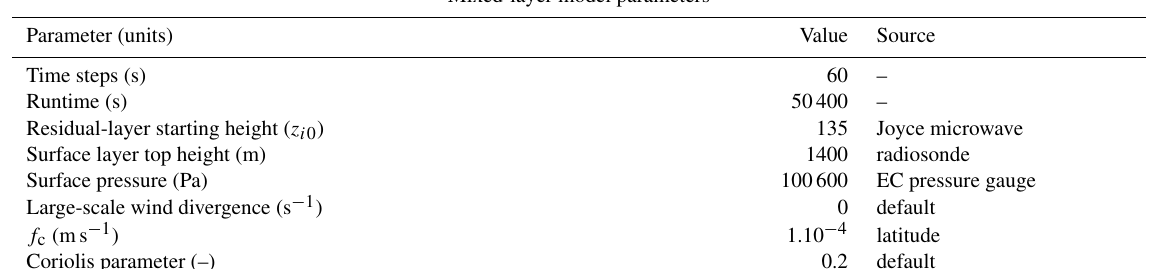
Table A2. Initial and boundary conditions prescribed in CLASS to reproduce IOP 1 (7 May 2018). Mixed-layer model